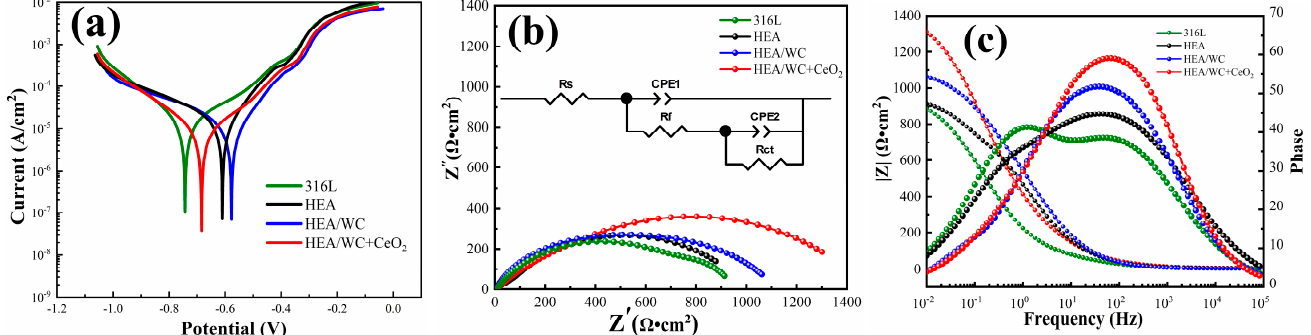
Figure 10. Microscopic morphology of the substrate and the three coating surfaces after wear: ( a – c ) 316L substrate; ( d – f ) HEA; ( g – i ) HEA/WC; ( j – l ) HEA/WC + CeO 2 .